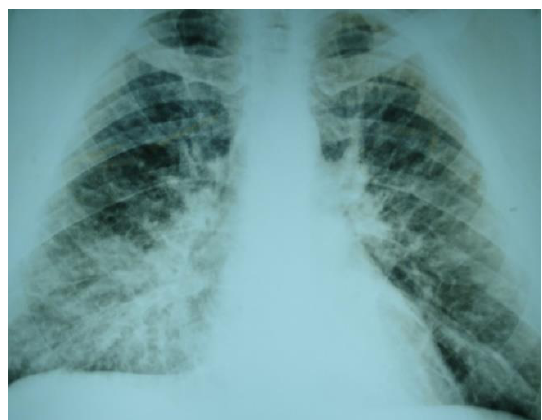
Figure 2. An X-ray of Patient 1 at the time of admission to the intensive care unit (ICU), Mato Grosso, Brazil, 2015